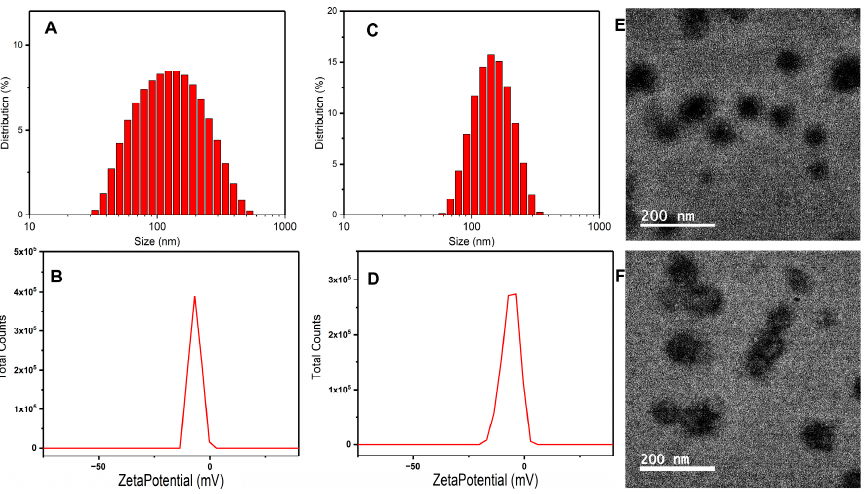
Figure 4. Characterization of FPD and SKN@ FPD NMs. Size of FPD NPs ( A ), SKN@ FPD NMs ( C ), and zeta potential FPD ( B ), and SKN@ FPD NMs ( D ) measured by DLS. TEM of FPD NMs ( E ) and SKN@ FPD NMs ( F ).